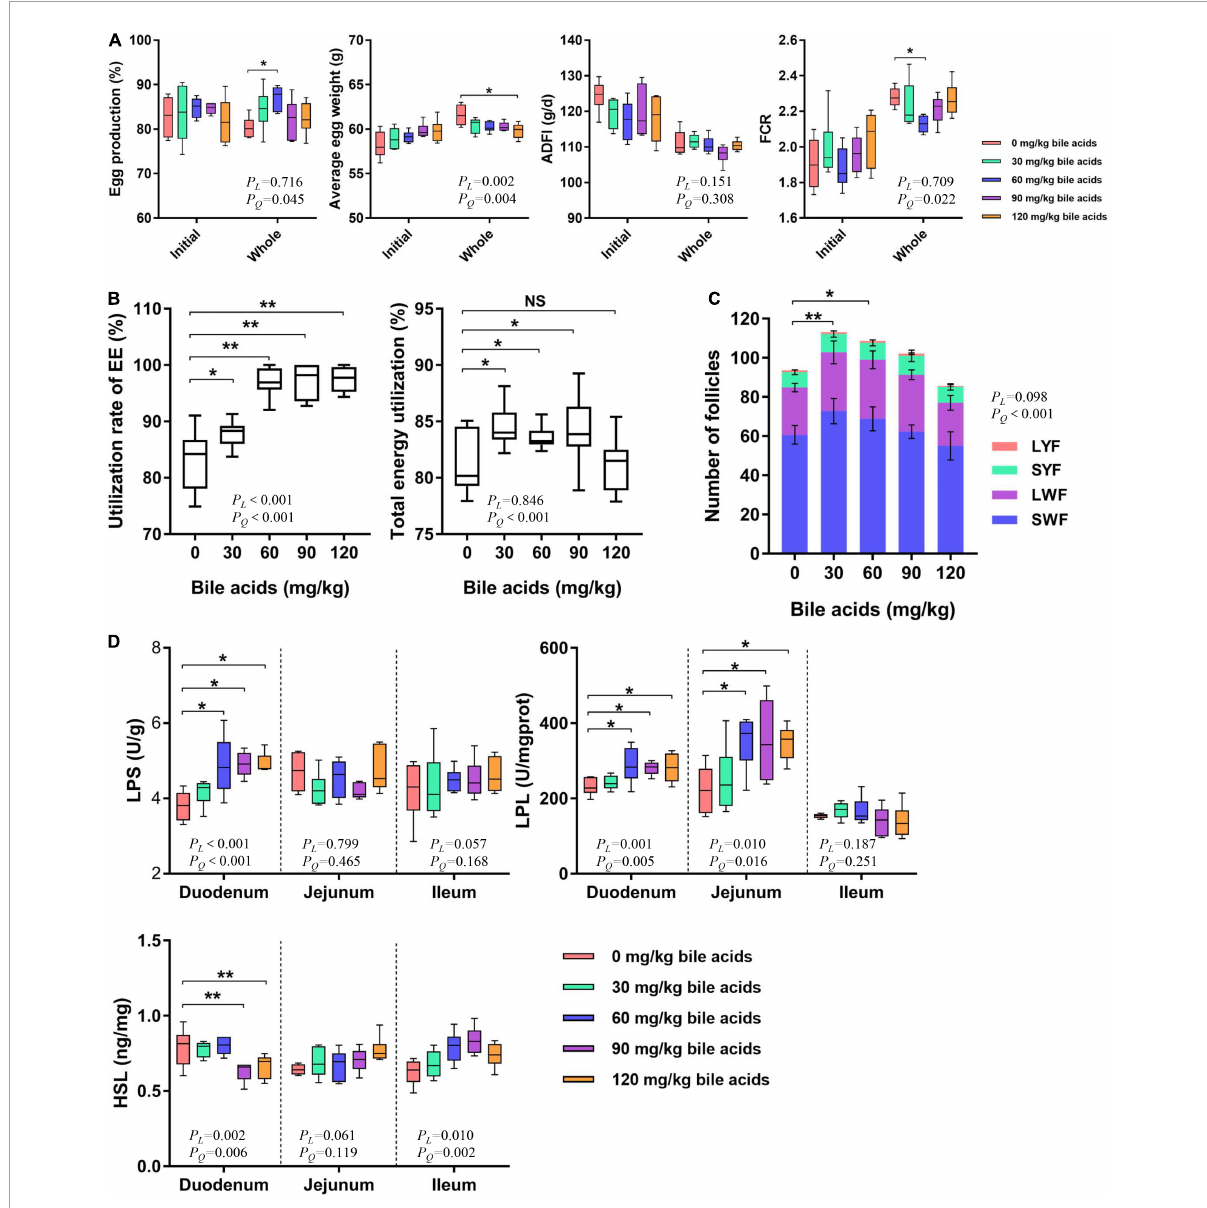
FIGURE2 Porcine bile acids improved laying performance by increasing intestinal lipase activity and increasing crude fat utilization. ADFI, average daily feed intake. FCR, feed conversion rate. EE, ether extract. LYF, large yellow follicle. SYF, small white follicle. LWF, large white follicle. SWF, small white follicle. LPS, lipase. LPL, lipoprotein lipase. HSL, hormone-sensitive lipase. P L , linear P -value. P Q , quadratic P -value. (A) Porcine bile acids improved laying performance of laying hens. (B) Porcine bile acids enhanced crude fat and total energy utilization. (C) Porcine bile acids increased the number of follicles. Values are indicated as means ± SD. (D) Porcine bile acids improved the activity of lipase in the small intestine. (A,B,D) Each box represents the mean value of six hens each treatment ( n = 6). Whiskers represent maximum and minimum. Different at P < 0.05 is marked as * and P < 0.01 is marked as